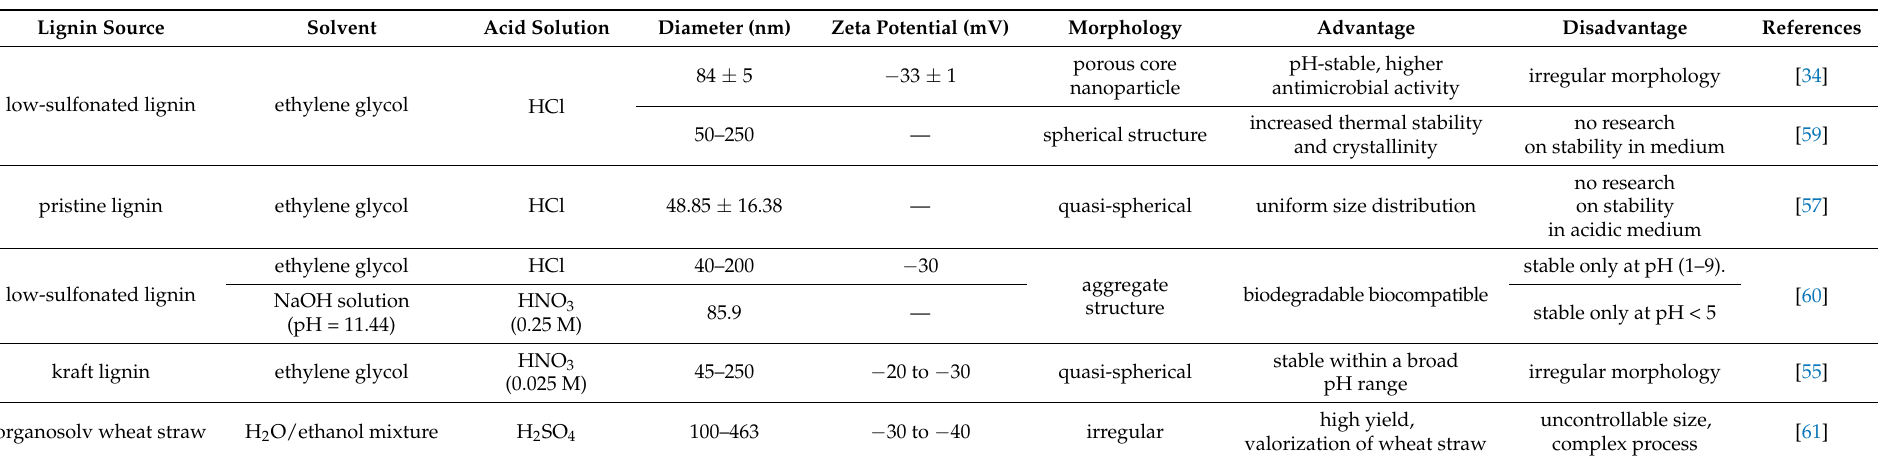
Table 2. Preparation of Lignin Nanoparticles by Using Acid Solution as